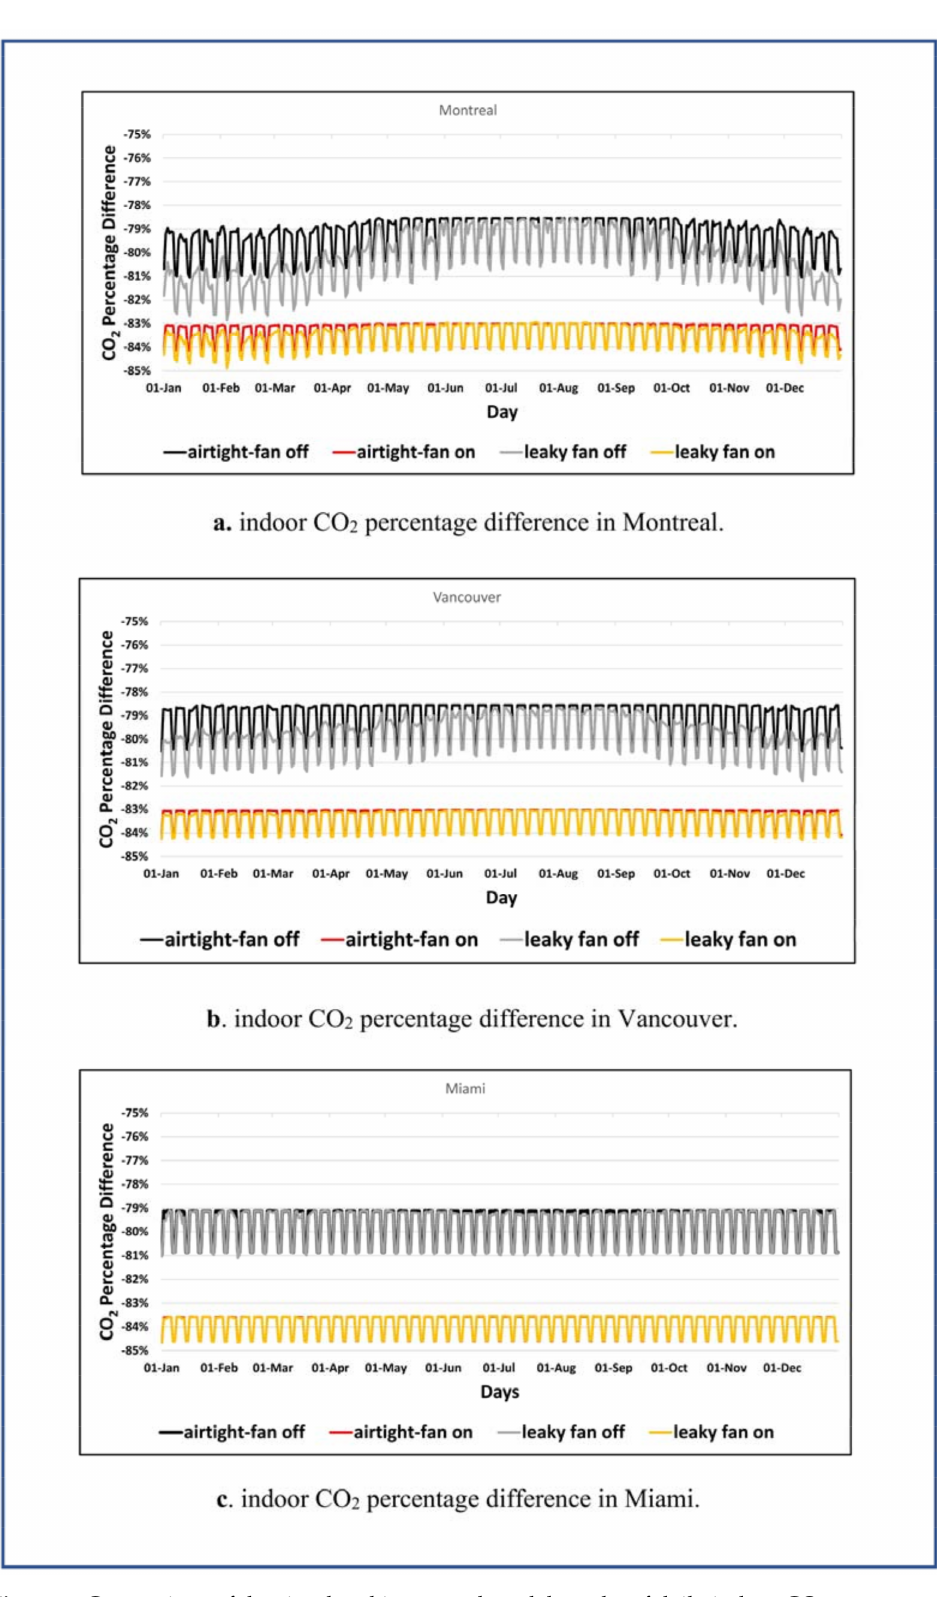
Figure 8. Comparison of the simulated integrated model results of daily indoor CO 2 concentration with acceptable level of ASHRAE Standard 62.1 for ( a ) Montreal, ( b ) Vancouver, and ( c )